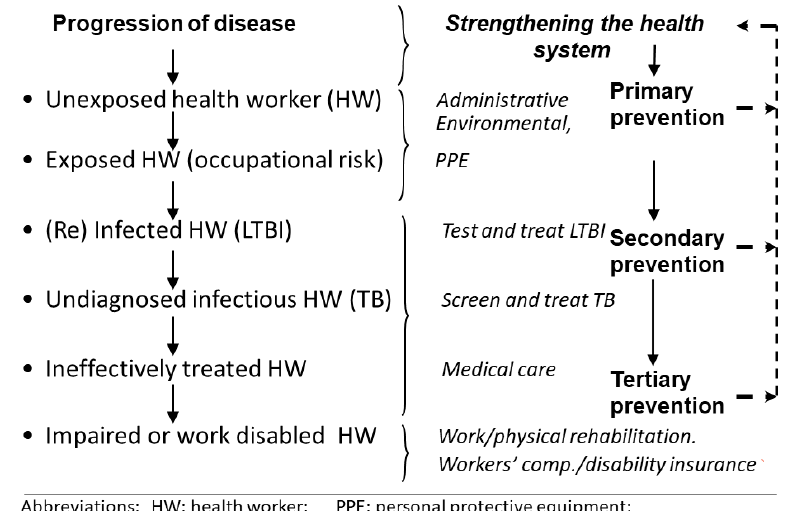
Figure 1. TB disease prevention schema.